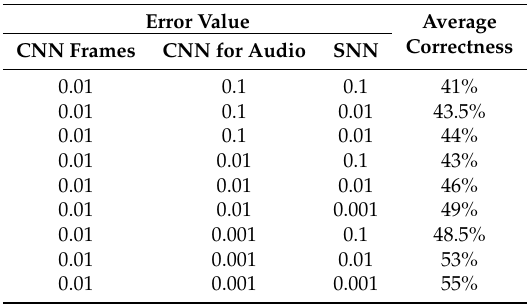
Table 2. Average correctness for various neural compositions applied for User 2.